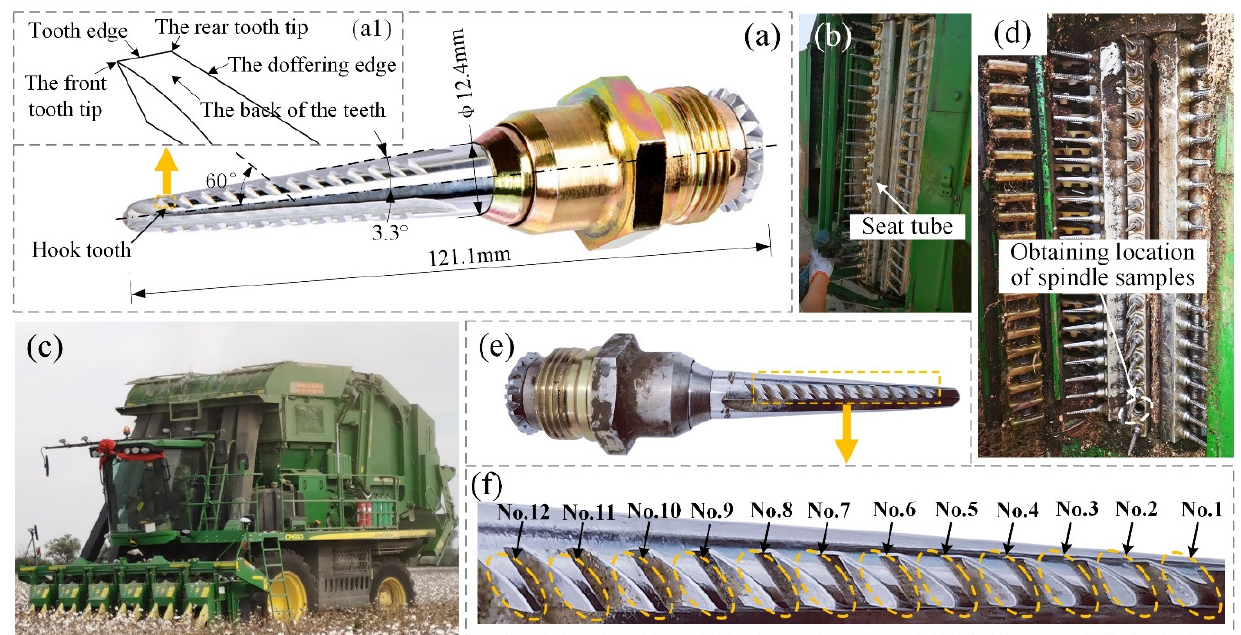
Figure 1. Installation and disassembly process of the spindle: ( a ) spindle assembly; ( a1 ) hook tooth structure; ( b ) seat tube of the front drum; ( c ) field work process of the cotton picker; ( d ) obtaining the location of the spindle samples; ( e ) spindle sample; and ( f ) number of spindle hook teeth. Table 1. Test equipment.